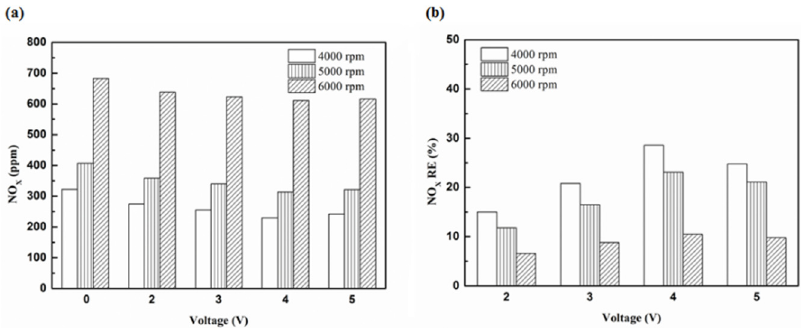
Figure 28. The NO x ( a ) emission values and ( b ) RE using platinum in the front of the exhaust pipe.